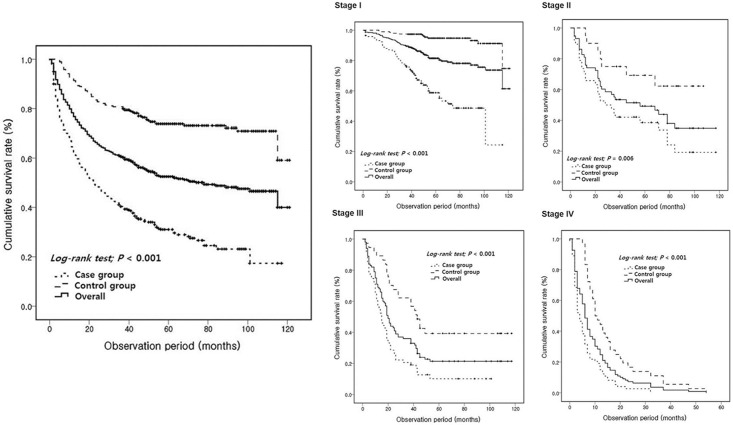
Cumulative survival rates between case and control groups.(A) Kaplan–Meier survival curve showing a significant difference in overall survival between the control and case groups (P<0.001). (B) Kaplan–Meier estimates of overall survival rates in patients of the control and case groups according to the tumor stage. The case group showed significantly lower survival rates at each stage than the control group (stage I, P<0.001; stage II, P = 0.006; stage III, P<0.001; and stage IV, P<0.001).